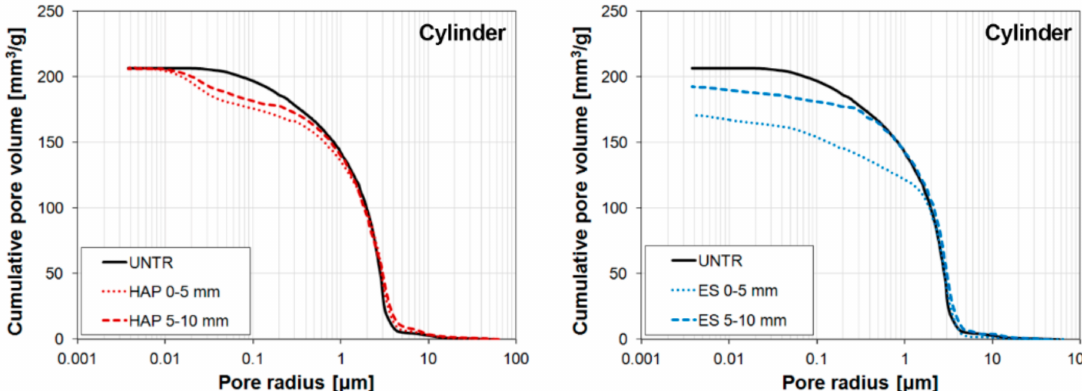
Figure 9. Alterations in pore size distribution of Globigerina limestone treated with a 3 M DAP solution, followed by a limewater poultice (“HAP,” left) and with a commercial ethyl silicate (“ES,” right), in comparison with the untreated reference (“UNTR”). Both consolidants were applied by brushing 10 times cylindrical samples (50 mm height, 20 mm diameter) on their lateral surface. The pore size distribution was determined by mercury intrusion porosimetry (MIP) on samples obtained at increasing depth from the treated surface. The “ES” sample was left to cure for 1 month before testing. Image adapted from Reference [49] with permission from